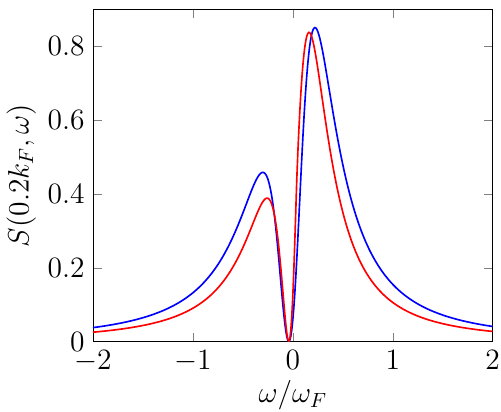
/π in a homogeneous system (blue line) against Figure 8: Plot of S ( k , ω ) at density n = k F S ( k , ω ) in a trap as computed using the LDA (red line). We see that while the trap effects small quantitative changes on S ( k , ω ) , it leaves the overall line shape